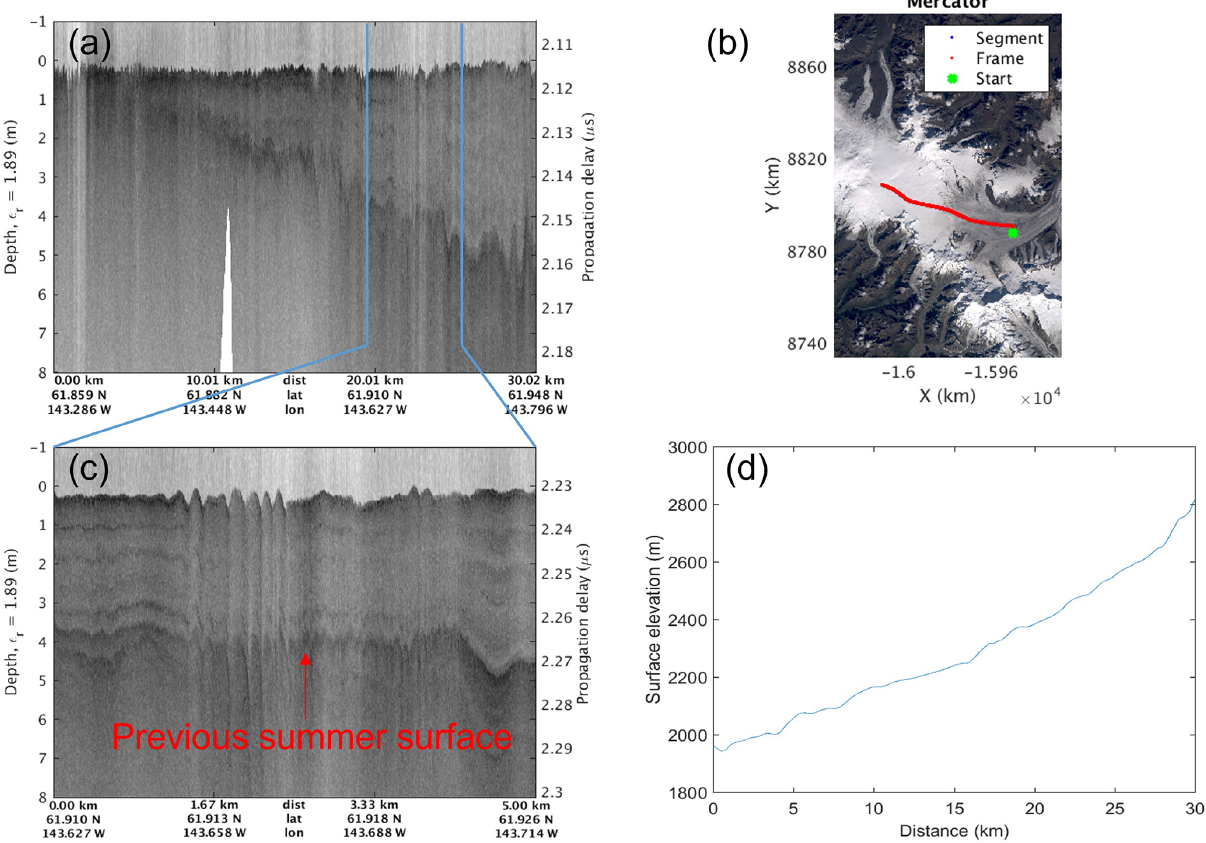
Figure 11. (a) Observations from the east of Mount Wrangell to Nabesna Glacier. (b) The flight line plotted in red on the Landsat image map. (c) The radar echogram image with clear strata details for the portion between 20 and 25km in (a) . (d) The surface elevation profile along the flight